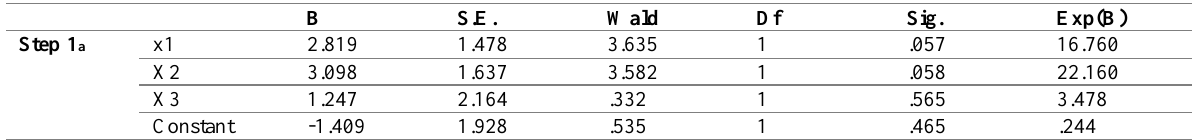
Table 1: Parameters of porters variables in the logit regression equation B S.E. Wald Df Sig. Exp(B) x1